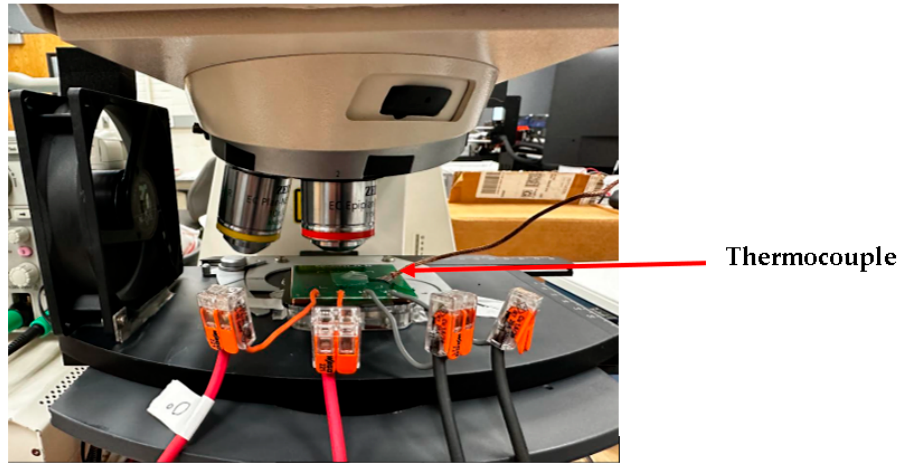
Figure 6. Thermal experiment setup.